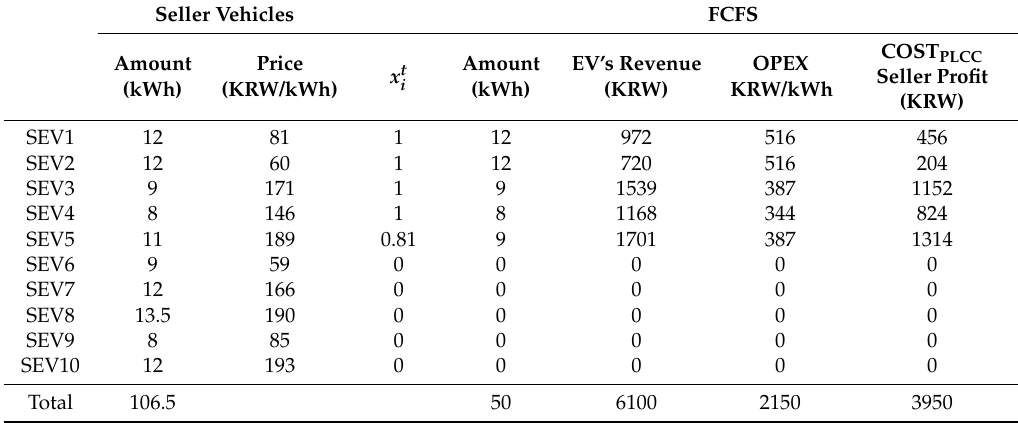
Table 6. Case (1) with the first-come-first-serve (FCFS) scheme for electric vehicles as sellers and the PLCC as a buyer.